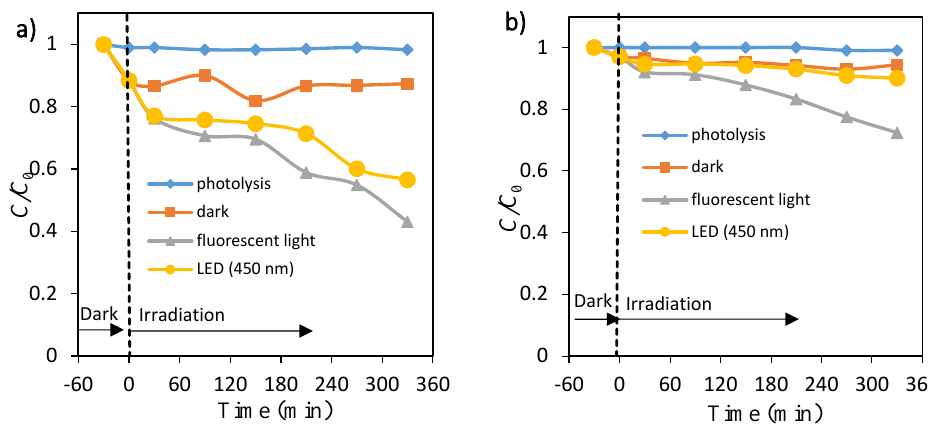
Figure 4. Time courses of concentration of orange II ( a ) and methyl orange ( b ). Photolysis: ♦ , ZnO dispersions: under dark ■ , under fluorescent light irradiation ▲ and under LED light irradiation ● .